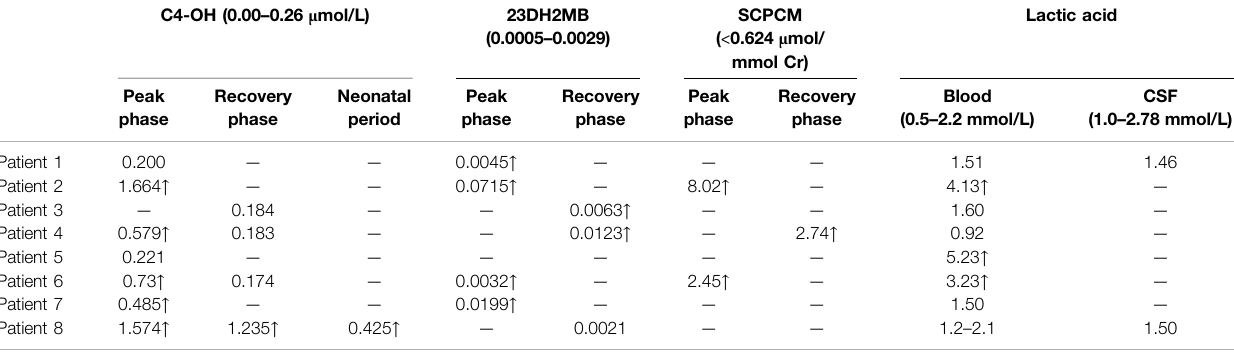
TABLE 2 | Metabolite results of extensive investigations of eight patients with HIBCH